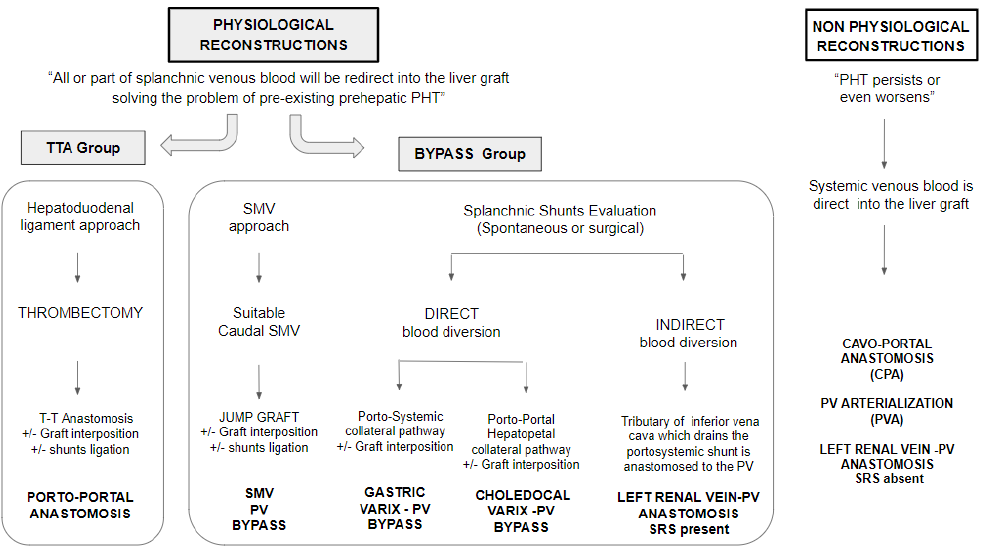
Figure 1. Classification of different portal reconstruction techniques according to the type of splanchnic venous blood diversion.